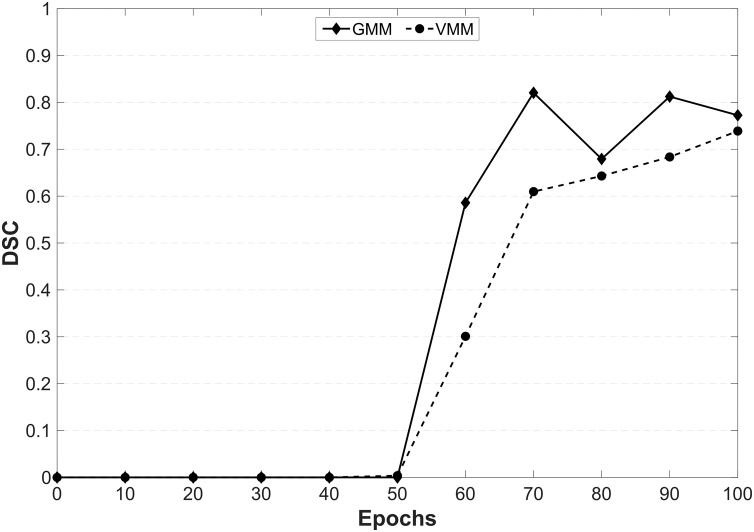
Influence of altering the loss objective during cGAN training on the segmentation performance of the medial gastrocnemius and vastus muscles.The cGAN was trained with a LcGAN+λLL2 loss objective for 50 epochs followed by a further 50 epochs training with LcGAN+λLL1.Abbreviations: VMM - vastus medialis muscle, GMM – medial head of gastrocnemius muscle, DSC – Dice Similarity Coefficient